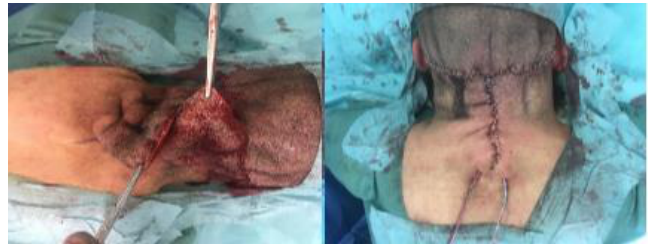
Figure 4. Surgical technique with the two laterals flaps peeled off in the sous cutaneous plane to the lateral border of the excess skin (intraoperative view).